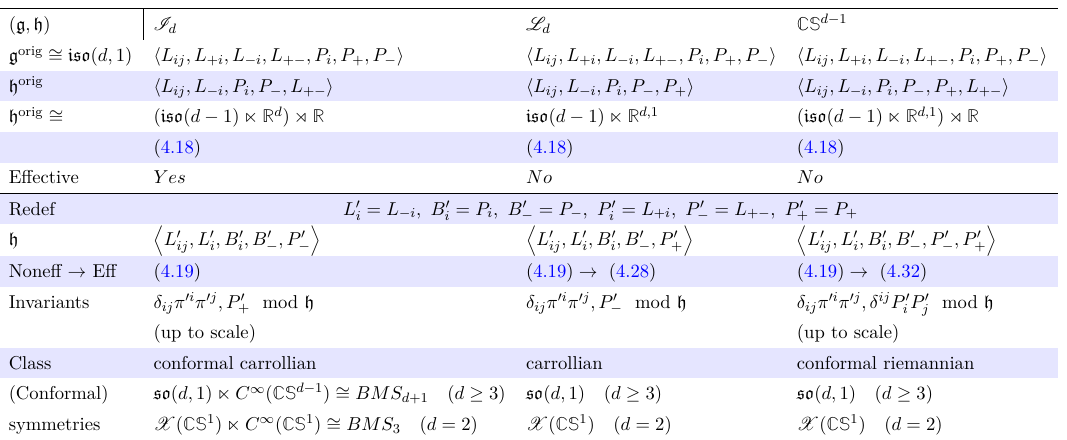
Table 3 . Overview of d and ( d − 1) -dimensional homogeneous spaces of the Poincaré group that descend from Ni d +1